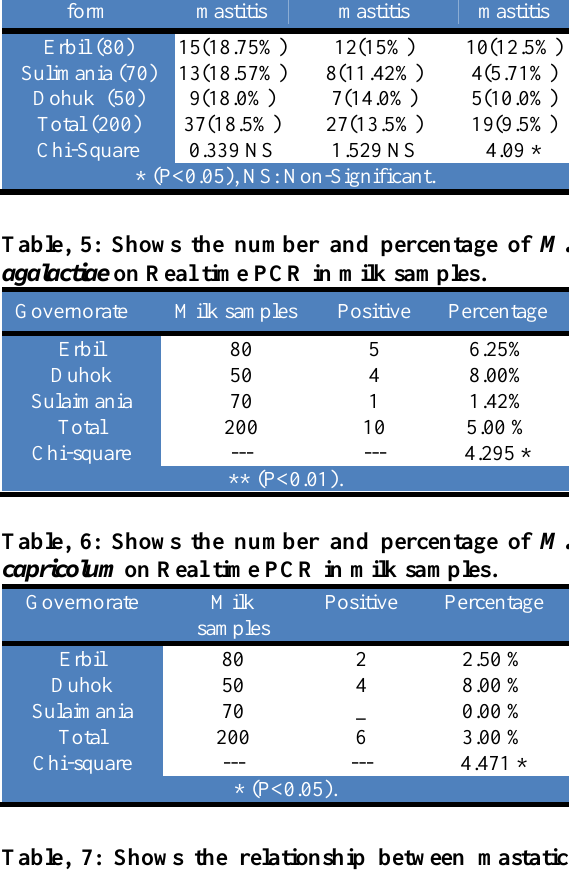
Table, 7: Shows the relationship between mastatic and non mastatic milk samples and positive M.